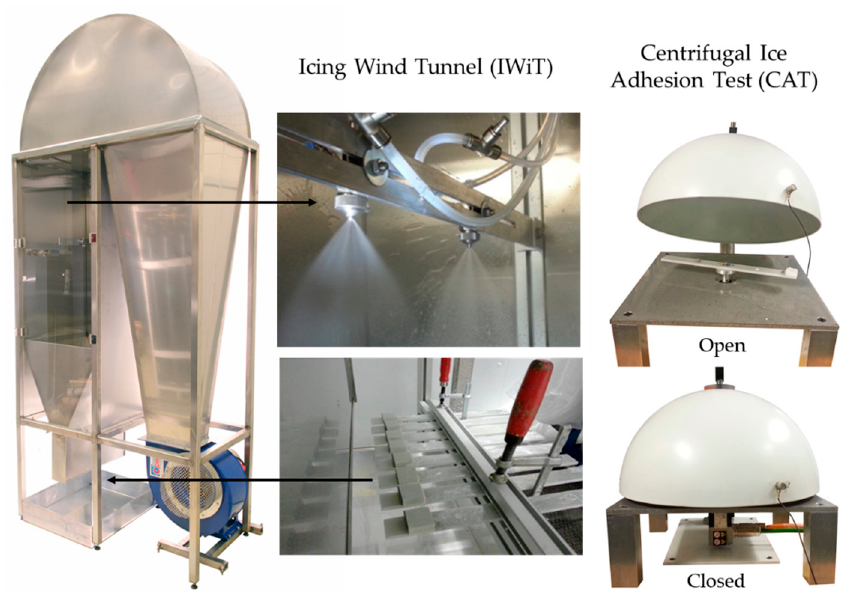
Figure 1. Icing Wind Tunnel (IWiT) and Centrifugal Ice Adhesion Test (CAT) at Tampere University.